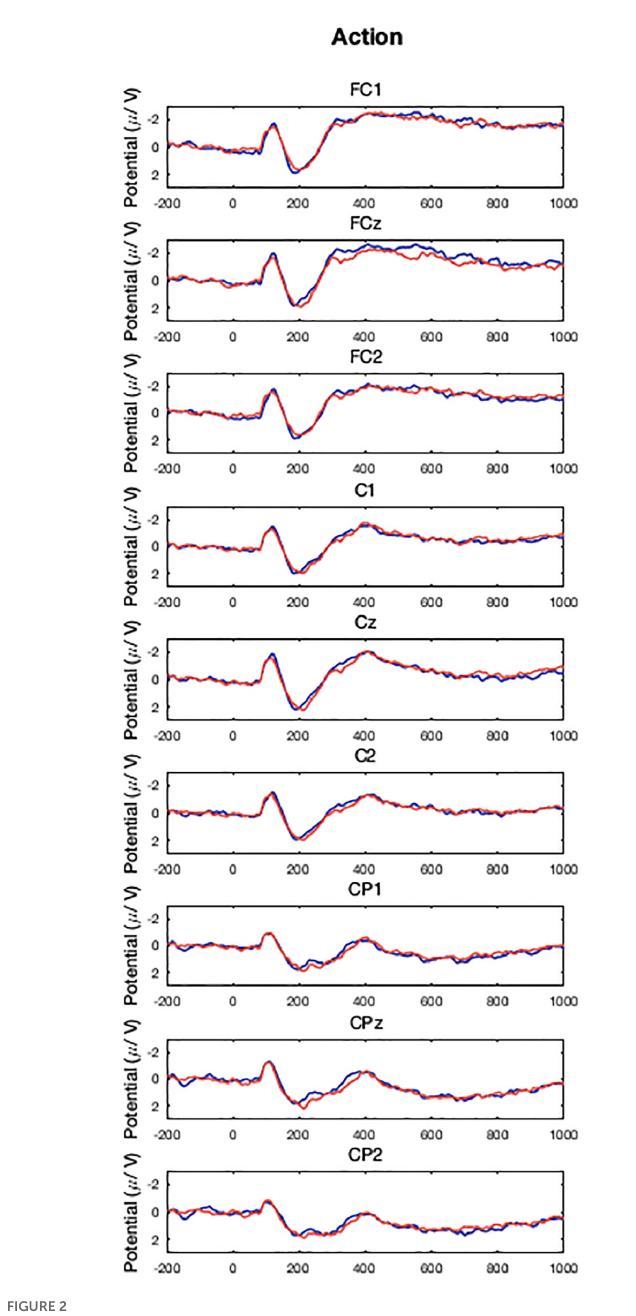
window [ χ 2 (2) = 13.08, p = 0.001], so the degrees of freedom